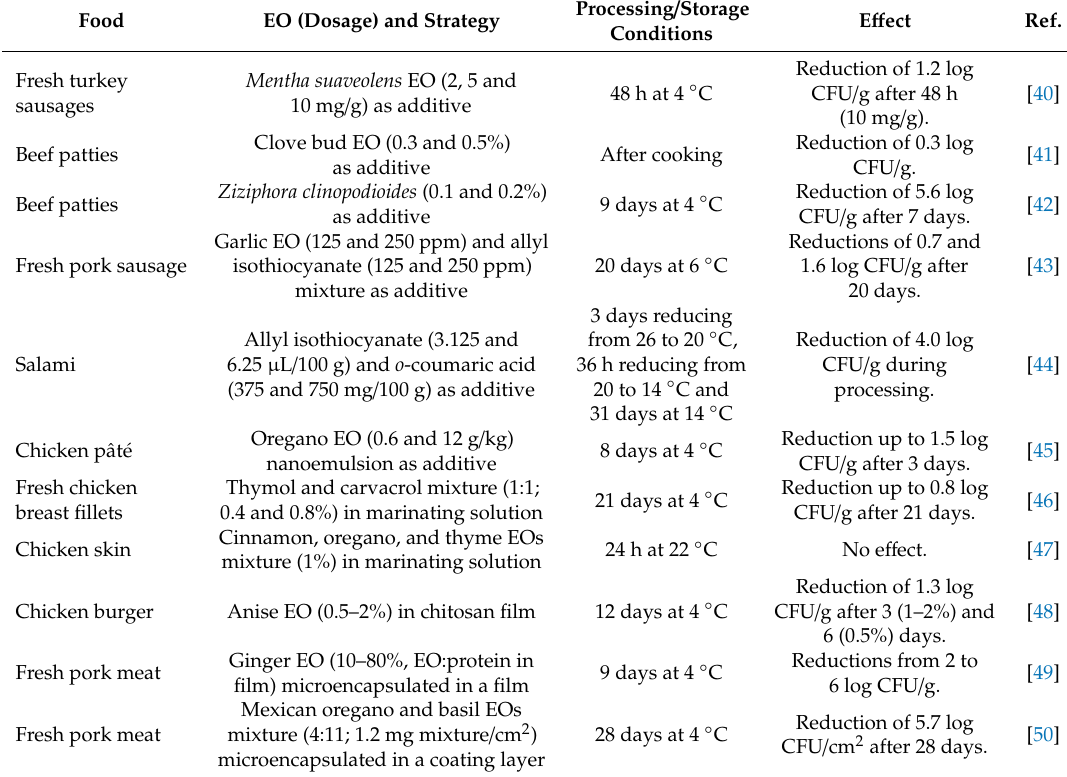
Table 2. Influence of essential oils on E. coli strains in meat and meat